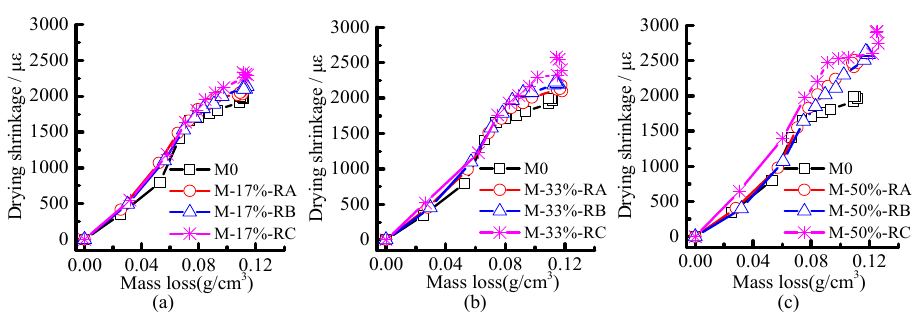
Figure 10. Relationship between mass loss and drying shrinkage of rubberized mortars, ( a ) M-17%; ( b ) M-33%; ( c ) M-50%.